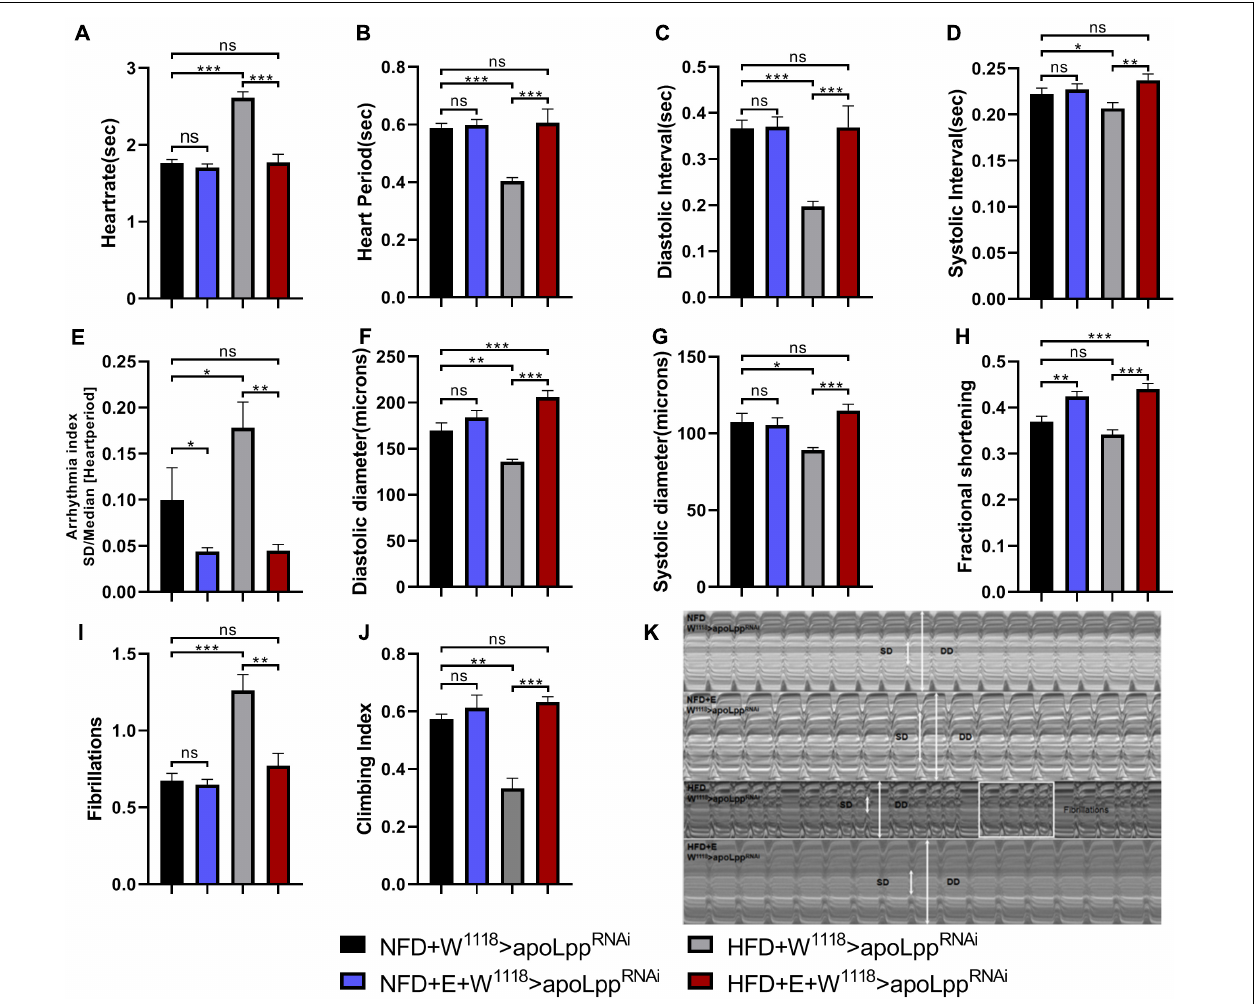
FIGURE 2 | Changes in heart function, climbing ability, and TG levels of the W 1118 > apoLpp RNAi group under different conditions. (A–I) The M-mode indicators under different treatments are HR, HP, DI, SI, AI, DD, SD, FS, and FL. All flies were females, The sample sizes of the four groups NFD, NFD + E, HFD, and HFD + E are N = 16, 18, 21, and 15. (J) represents the climbing ability of fruit flies under different treatments. The value of the histogram is the climbing index. For calculation of the climbing index, see section “Materials and Methods.” All fruit flies were females, N = 50. (K) M-mode cardiogram of Drosophila under different treatments. The short arrow is the systolic diameter, the long arrow is the diastolic diameter, and the rectangle is the fibrillary tremor. The interception of M-mode cardiogram for each group is 10 s. All P -values are derived from two-way ANOVA. LSD was used for post-hoc testing. * P < 0.05, ** P < 0.01, *** P <